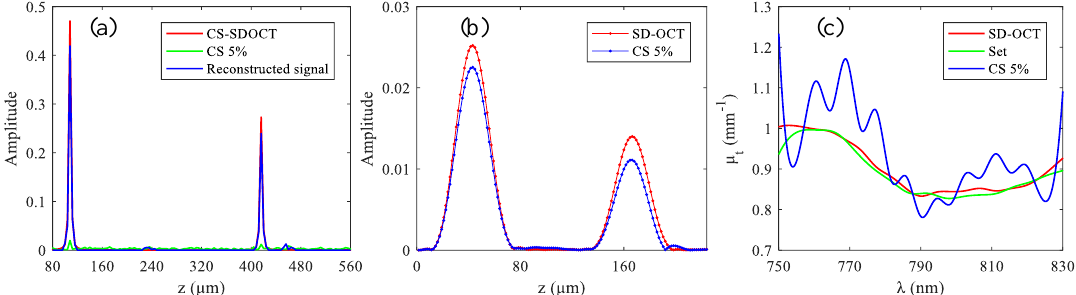
Figure 5. Simulation results of functional sensing sampling rate is 5%. ( a ) The signals obtained by IFFT processing of spectral data; ( b ) the signals obtained by STFT processing of spectral data; and ( c ) spectrum of extinction coe ffi cient µ t ( k )